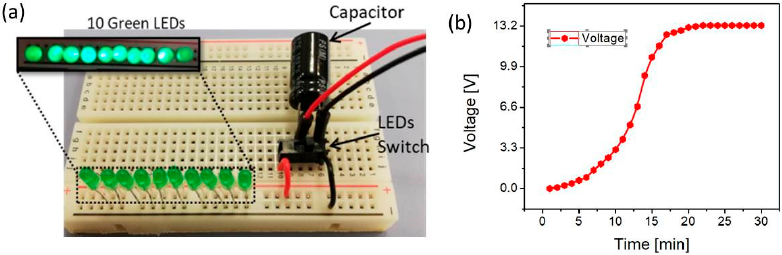
Figure 7. ( a ) 10 green LEDs glowed with harvested energy. ( b ) Harvested voltage across the